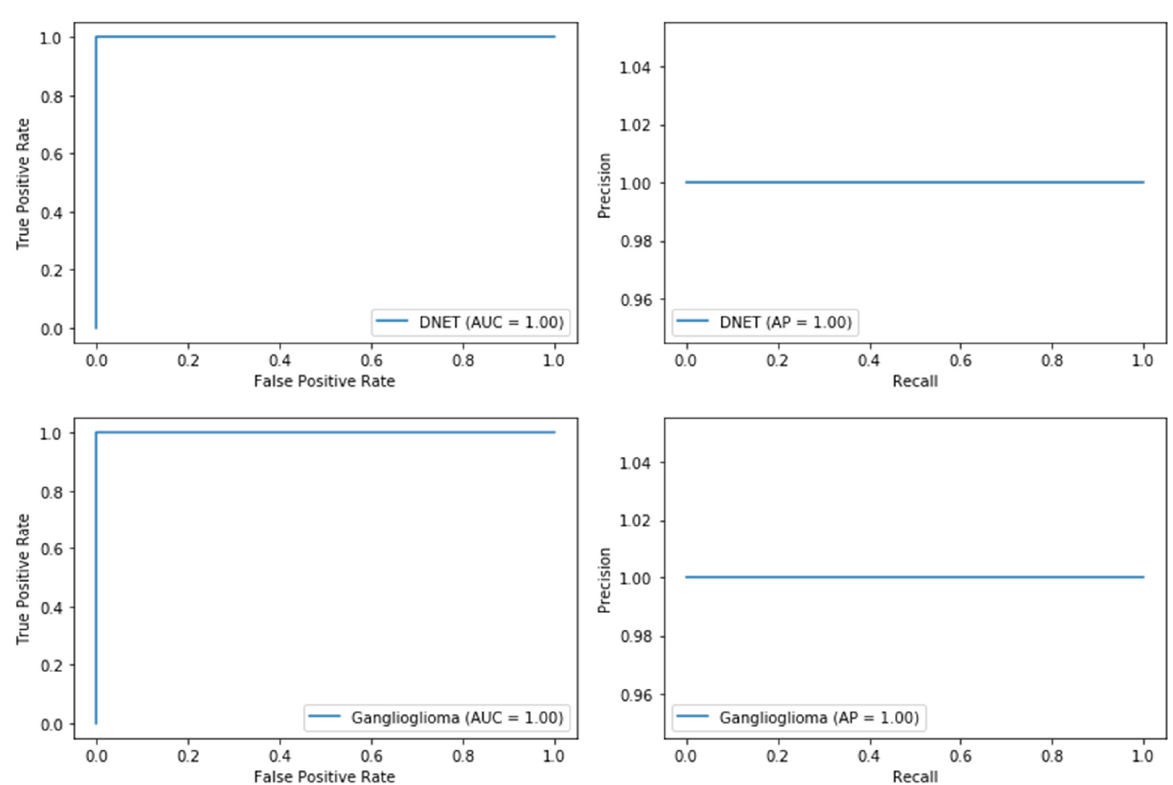
Figure 8. Results | ROC ( left ) and precision recall curves ( right ) on slide level.